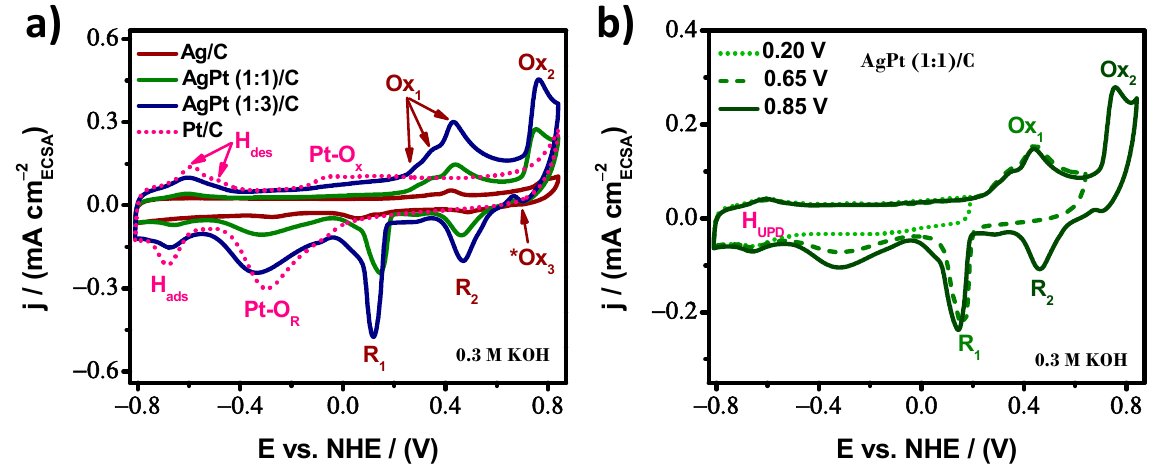
Figure 5. Cyclic voltammograms profiles in 0.3 M KOH solution at 50 mVs − 1 ; ( a ) for AgPt/C system, and ( b ) at the different anodic potential limits for AgPt (1:1)/C. Table 1. Electrochemically active surface area, mass activity, and specific activity of the different electrocatalysts.